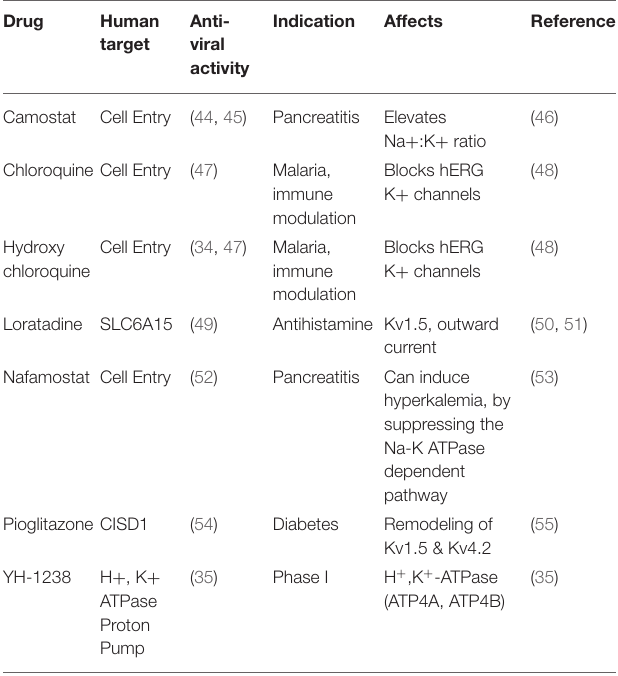
TABLE 1 | Repurposed drugs with anti-viral activity that also affect potassium balance.